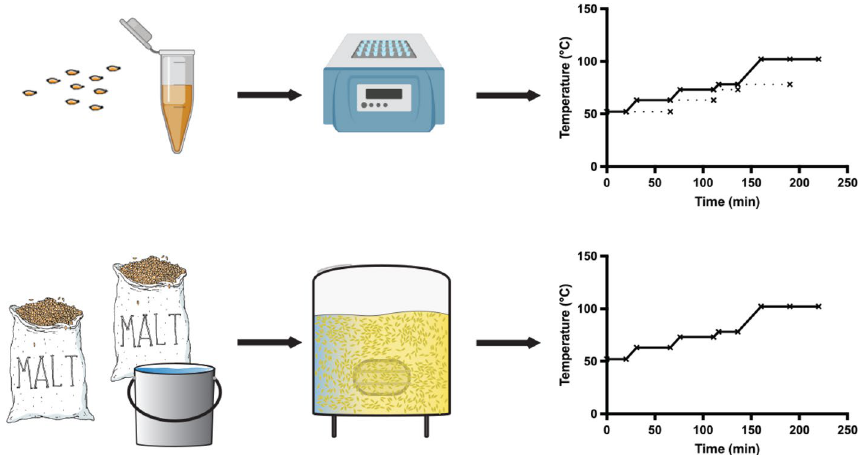
Figure 1. Process and throughput of micro-scale mash compared with a standard Braumeister